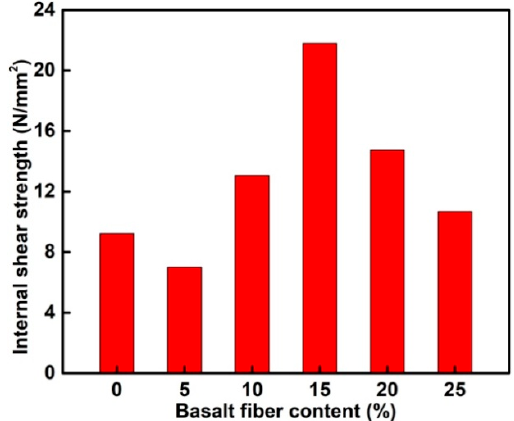
Figure 2. Internal shear strength of the friction composites.